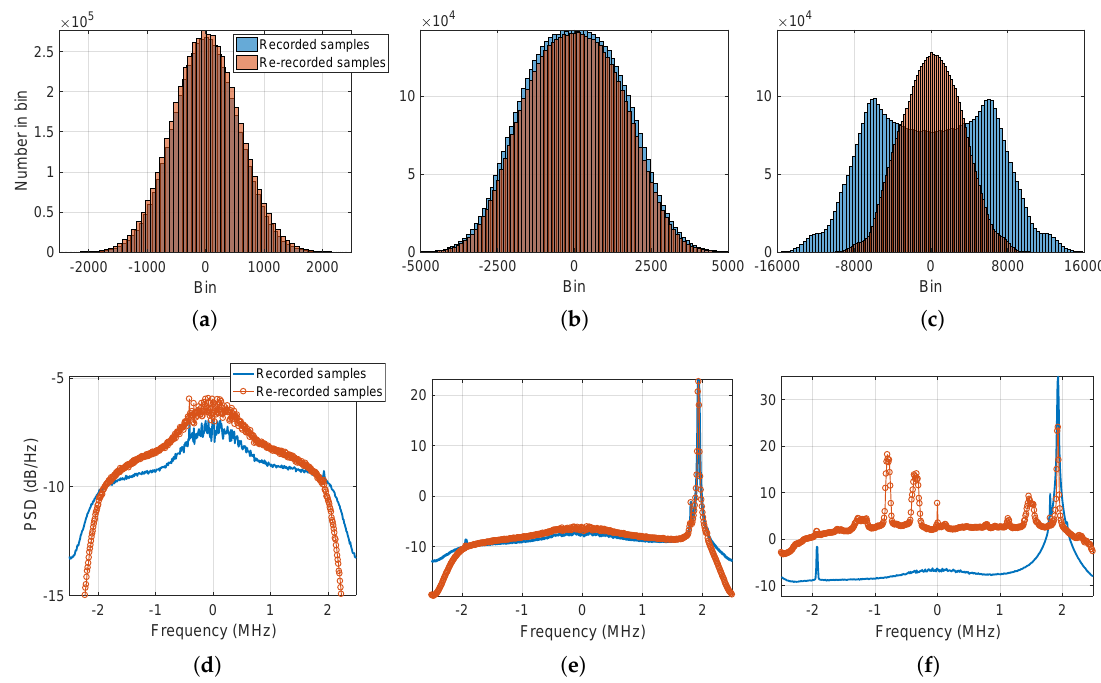
Figure 13. Test case for the urban environment. Histograms ( top ) and PSDs ( bottom ) of the recorded and re-recorded GNSS raw samples at seconds 155 ( left ), 351 ( middle ), and 353 ( right